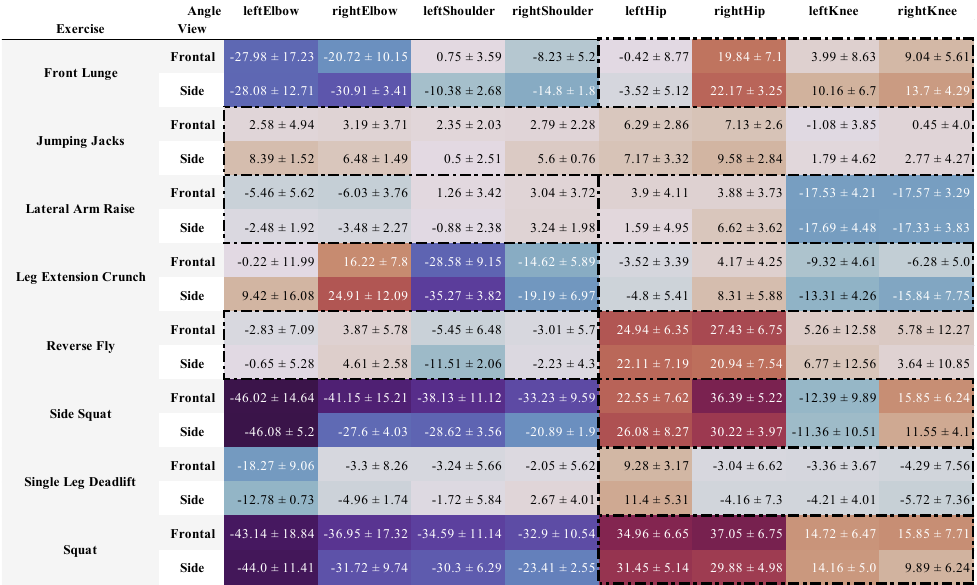
Figure A3. Pivot Table of the average Mean Error (ME) distributed over the eight exercises and the eight tracked angles, each measured from the two iPad perspectives Frontal and Side . The dashed boxes indicate which joints were specifically targeted by the respective exercise. The heatmap visualizes the performance of the individual joints per exercise, with darker purple color hinting at underestimation and darker orange color hinting at overestimation. Values closer to zero either indicate good performance or error cancellation.